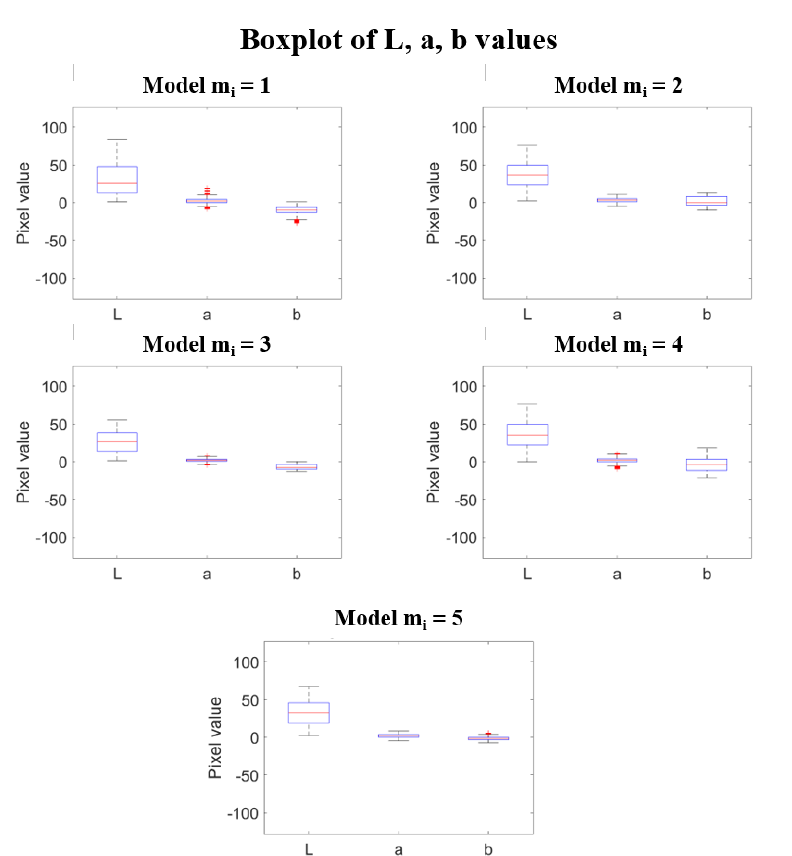
Figure 7. Boxplot of L, a and b values used to define the 3D polyhedra for each model.